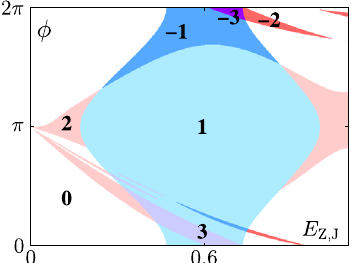
FIG. 5. A phase diagram of the system as a function of the Zeeman field and ϕ in the presence of the mirror symmetry M y defined in the text. The values of the Z invariant corresponding to each region are indicated on the figure. Regions with odd (even) Z indices, corresponding to topological (trivial) regions of the D class, are filled with shades of blue (red). Note that, by our definition of ϕ , the phase diagram is not invariant under ϕ → ϕ þ 2 π since this operation flips the sign of the superconducting gap function. The figure was obtained using a tight-binding version of the model (see Appendix D 2) with the following 5 , t ¼ 1 , α ¼ 0 . 5 , μ ¼ − 2 . 75 , and parameters: W ¼ 5 , W SC ¼ Δ ¼ 0 . 3 . Note that normal reflection is implicitly present in this model because of the finite width of the superconductors.